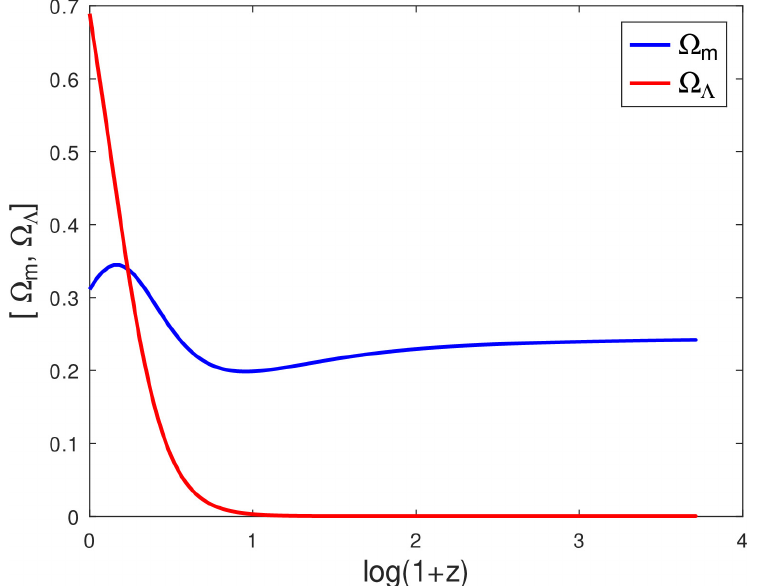
Figure 2. The variation of Ω m and Ω Λ for viscous Bianchi type-V cosmological model vs. redshift.